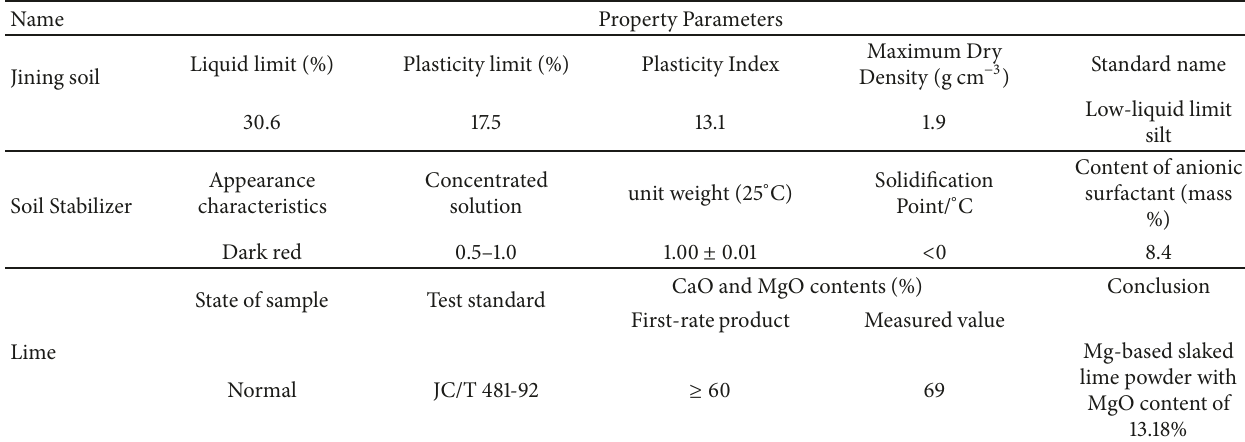
Figure 9: Relationship between allowable traffic passes and CBR of soil base (aircraft in design). Table 3: Main components and properties of soil